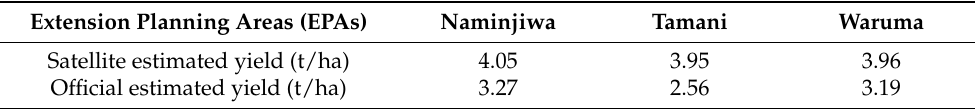
Figure 9. Yield estimates for maize fields using the linear model with the highest accuracy developed from the Sentinel-2 CIgreen index (Figure 7b). White areas represent non-maize fields. Table 3. Comparison between satellite data estimated maize yield by using red-edge VIs at spatial resolution of 10 m (R 2 = 0.52, nRMSE = 19.95%) and official maize yield estimates at the EPA administrative level.